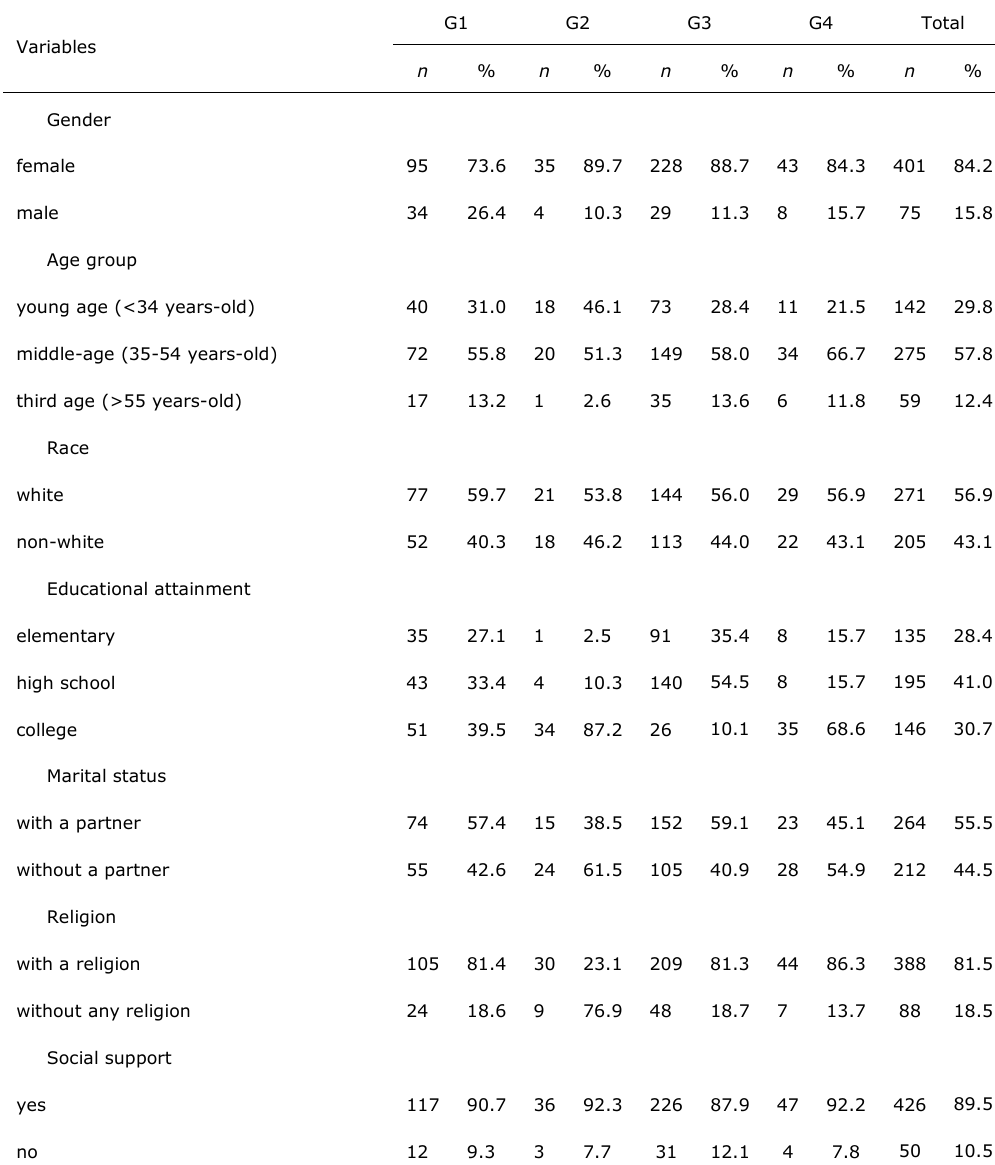
Table 1. Participants’ sociodemographic characteristics ( n =